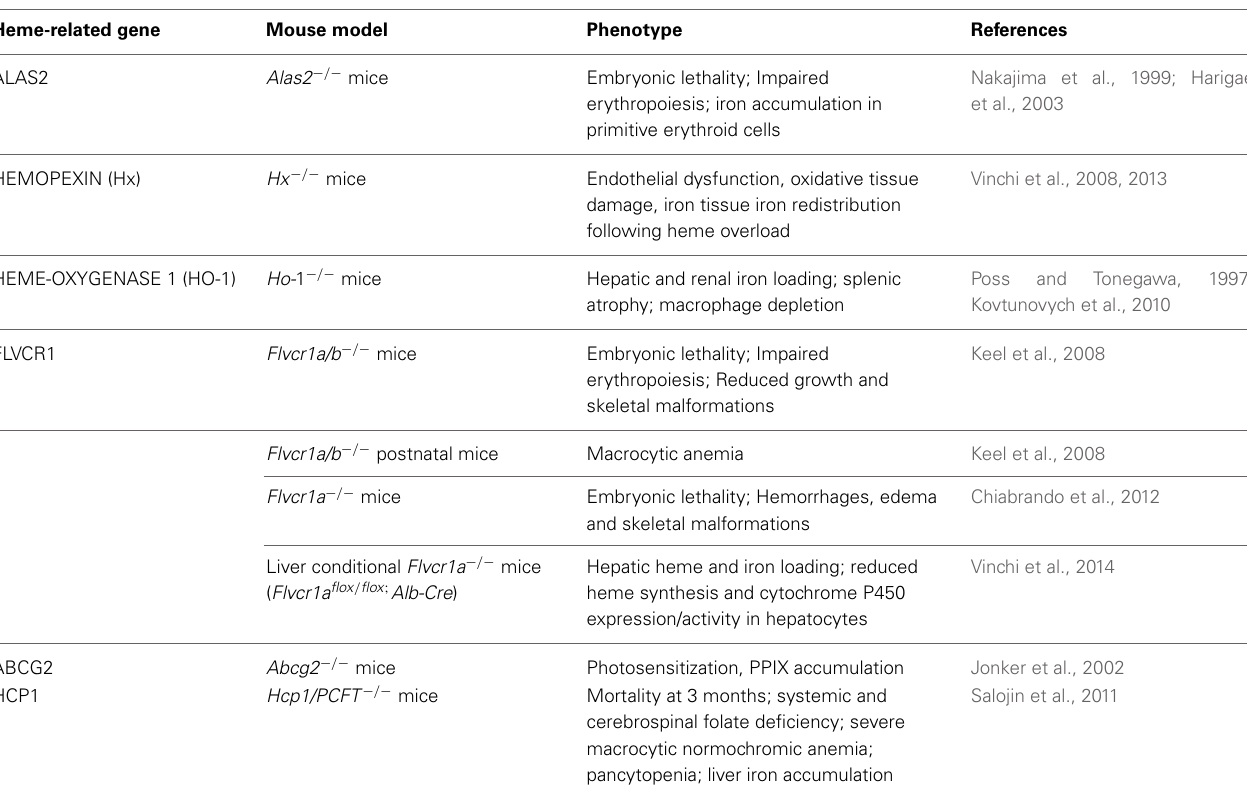
Table 1 | Mouse models deficient for genes involved in the control of heme homeostasis. Heme-related